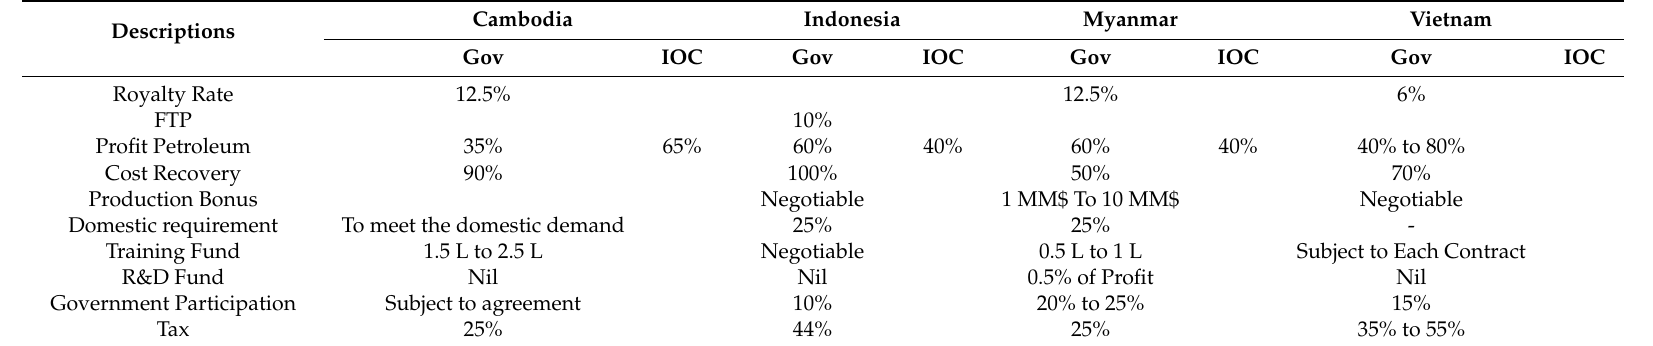
Table 3. Petroleum Fiscal Terms of PSC